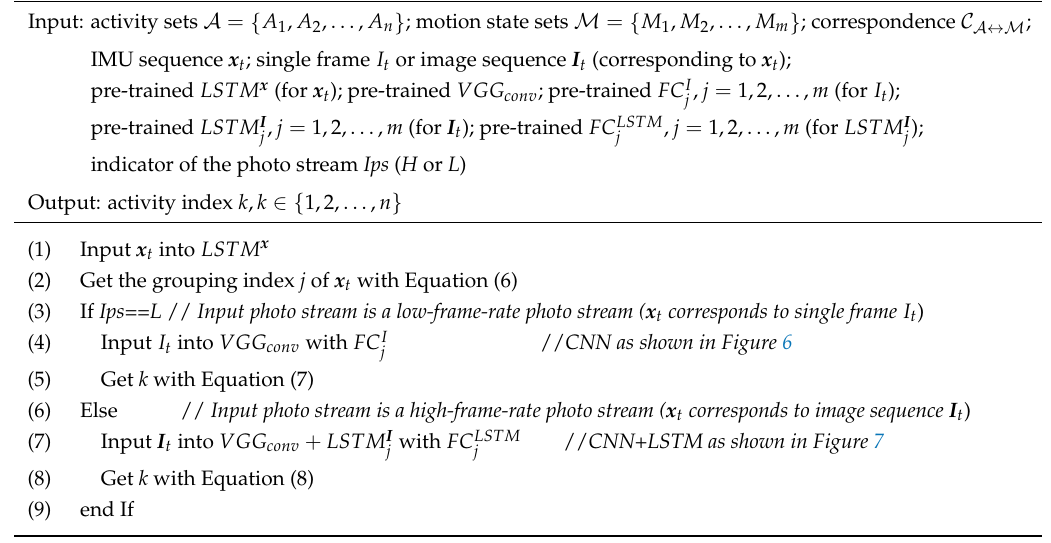
Algorithm 1 : Algorithm flow of the proposed hierarchical deep fusion framework.